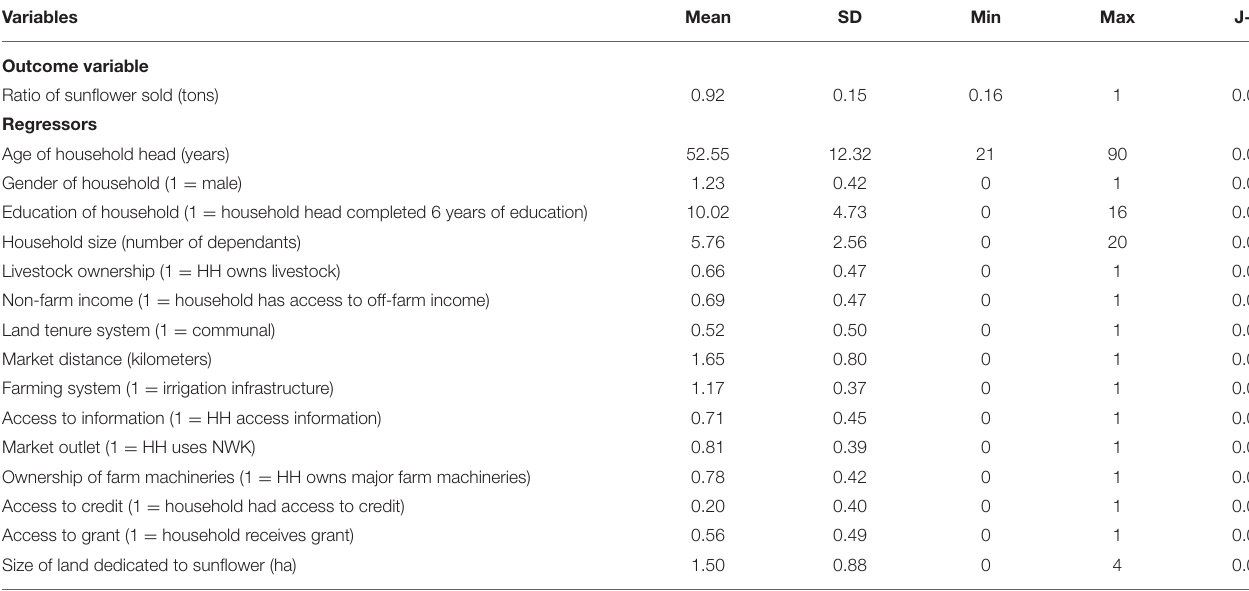
TABLE 2 | Summary statistics of the variables used in the empirical analysis. Variables Mean Outcome